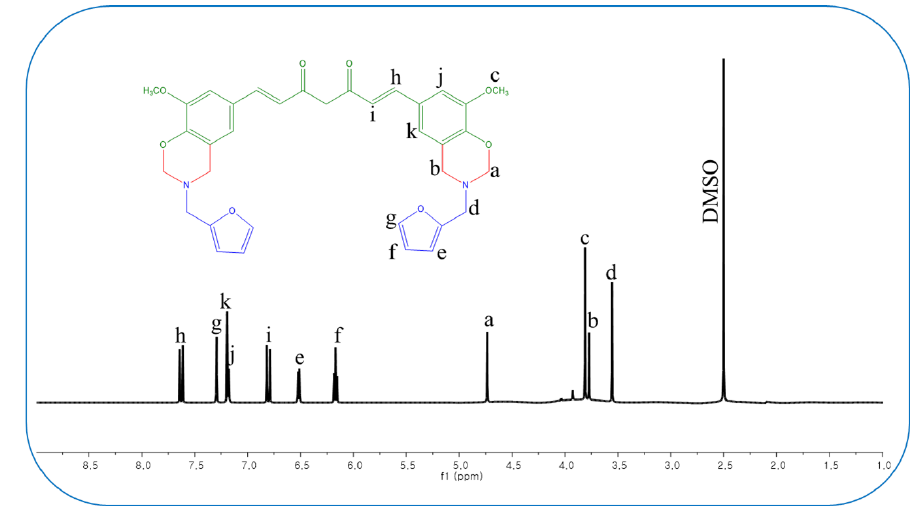
Figure 2. 1 H-NMR spectrum of C-fu benzoxazine.